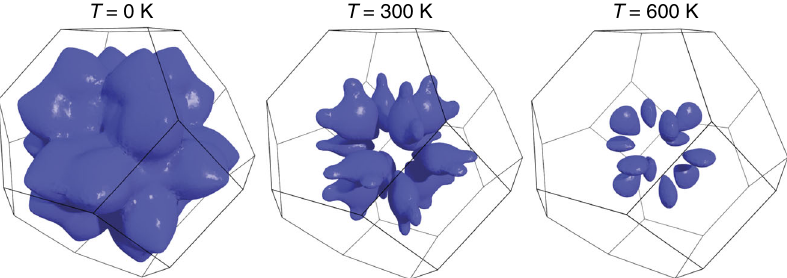
Fig. 4 Calculated phase space for three-phonon scattering processes in PbSe. This surface in the Brillouin zone represents the three-phonon scattering processes allowed by energy and momentum conservation for the transverse optic (TO) mode fi xed at the zone center, ω 1 = TO( Γ ), the longitudinal acoustic (LA) phonon, ω 2 = LA( q 2 ), and the TO phonon, ω 3 = TO( − q 1 − q 2 ). The surface represents allowed values for q 2 for a fi xed q 1 ( q 3 = − q 1 − q 2 is not shown). The resulting reduction in scattering phase space with increasing temperature provides an explanation for the observed decrease in LA phonon scattering rate and linewidth at high temperatures despite the increase in phonon